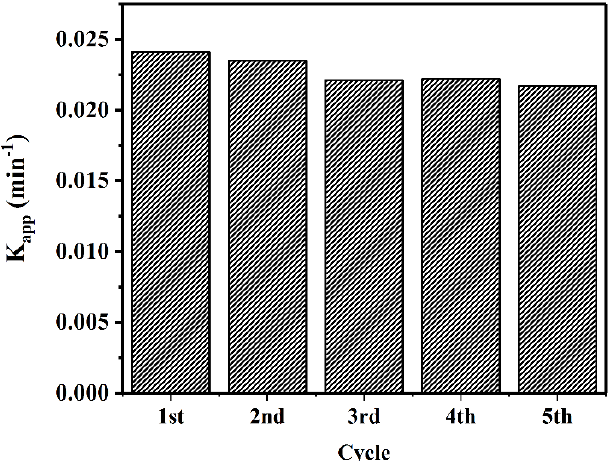
Figure 11. Reusability of the CuO–Cu 2 O sample under visible light irradiation during MB degradation.